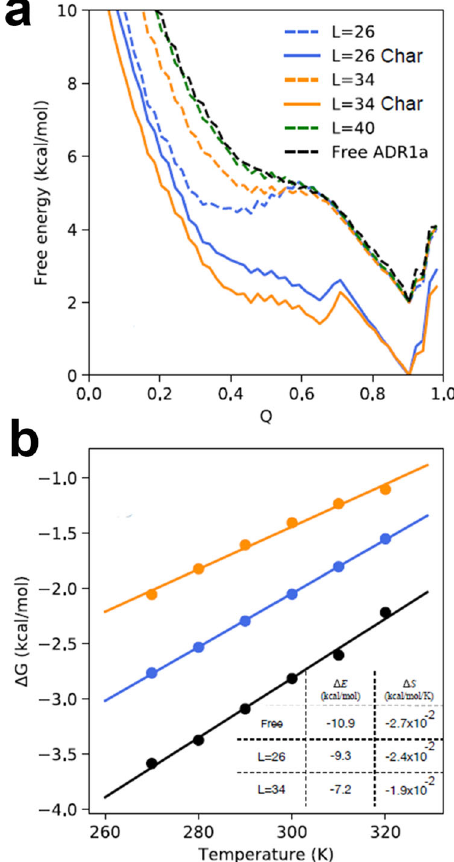
Fig. 5 Effect of ribosome on ADR1a free energy landscape. a Free energy pro fi les. Solid and dashed lines indicate results obtained with and without the inclusion of electrostatic interactions, respectively. The dashed curves are shifted vertically for visual clarity. b Temperature-dependent stability changes for ADR1a folding off (black) and on the ribosome with linker lengths of 26 (blue) and 34 (orange) amino